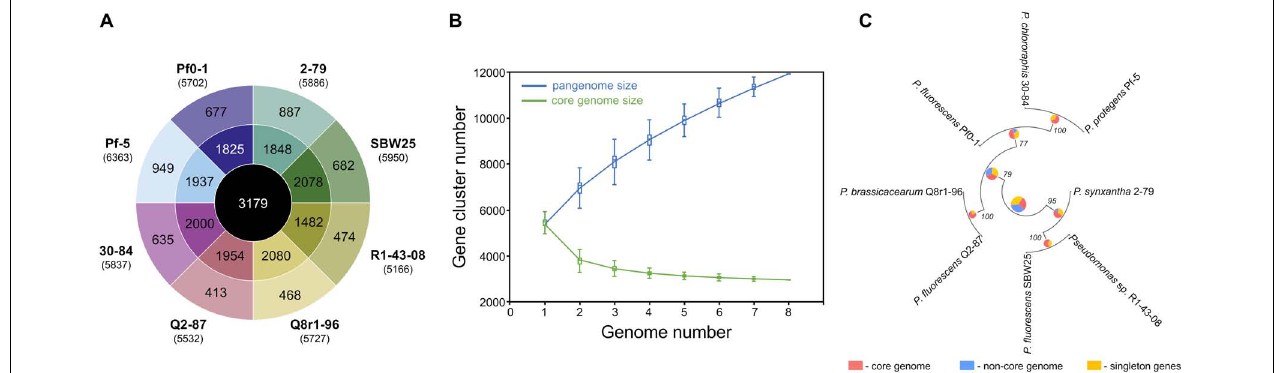
FIGURE 2 | Pangenome analysis of the studied Pseudomonas strains. (A) The innermost circle shows the number of orthologous protein families shared among all eight strains used in this study. The second circle shows orthologs present in two or more (but not all) strains, whereas the outermost circle represents strain-specific singletons. Values in brackets under strain names correspond to the total number of protein-coding genes predicted in each genome. (B) The gradual expansion of the pangenome (blue color) and contraction of the core genome (green color) following the sequential addition of genomes from the dataset. Box plots indicate the 25th and 75th percentiles and medians (horizontal lines) with whiskers corresponding to the 10th and 90th percentiles. The input order was randomized to avoid any bias due to the sequential addition of new genomes. The pangenome size increases steadily without reaching a plateau even after the addition of 11,939 non-redundant gene families. At the same time, the core genome converged to 3,179 genes. (C) The pangenome-based phylogenomic analysis of the studied strains. Here, the pangenome was defined with OrthoMCL, and orthologous gene sets were then partitioned into the core, singleton, and non-core (the remaining ortholog sets) categories. These categories were calculated for each node in the Maximum Likelihood species tree, using the set of genomes for which that node represents the ancestor. The results of the ortholog partitioning are shown in pie charts placed at tree nodes. Numbers indicate bootstrap support values. The analysis was conducted in KBase (Arkin et al.,